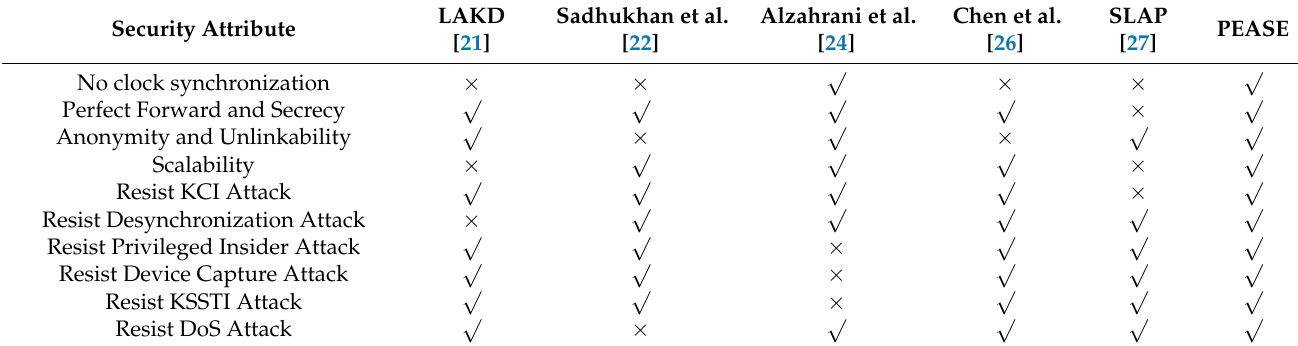
Table 5. Security comparison.